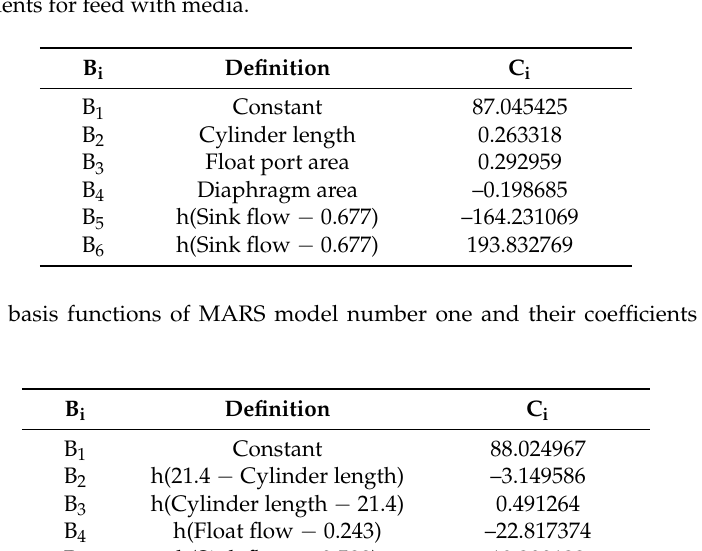
Table 1. List of basis functions of multivariate adaptive regression splines (MARS) model number one and their coefficients for feed with media.